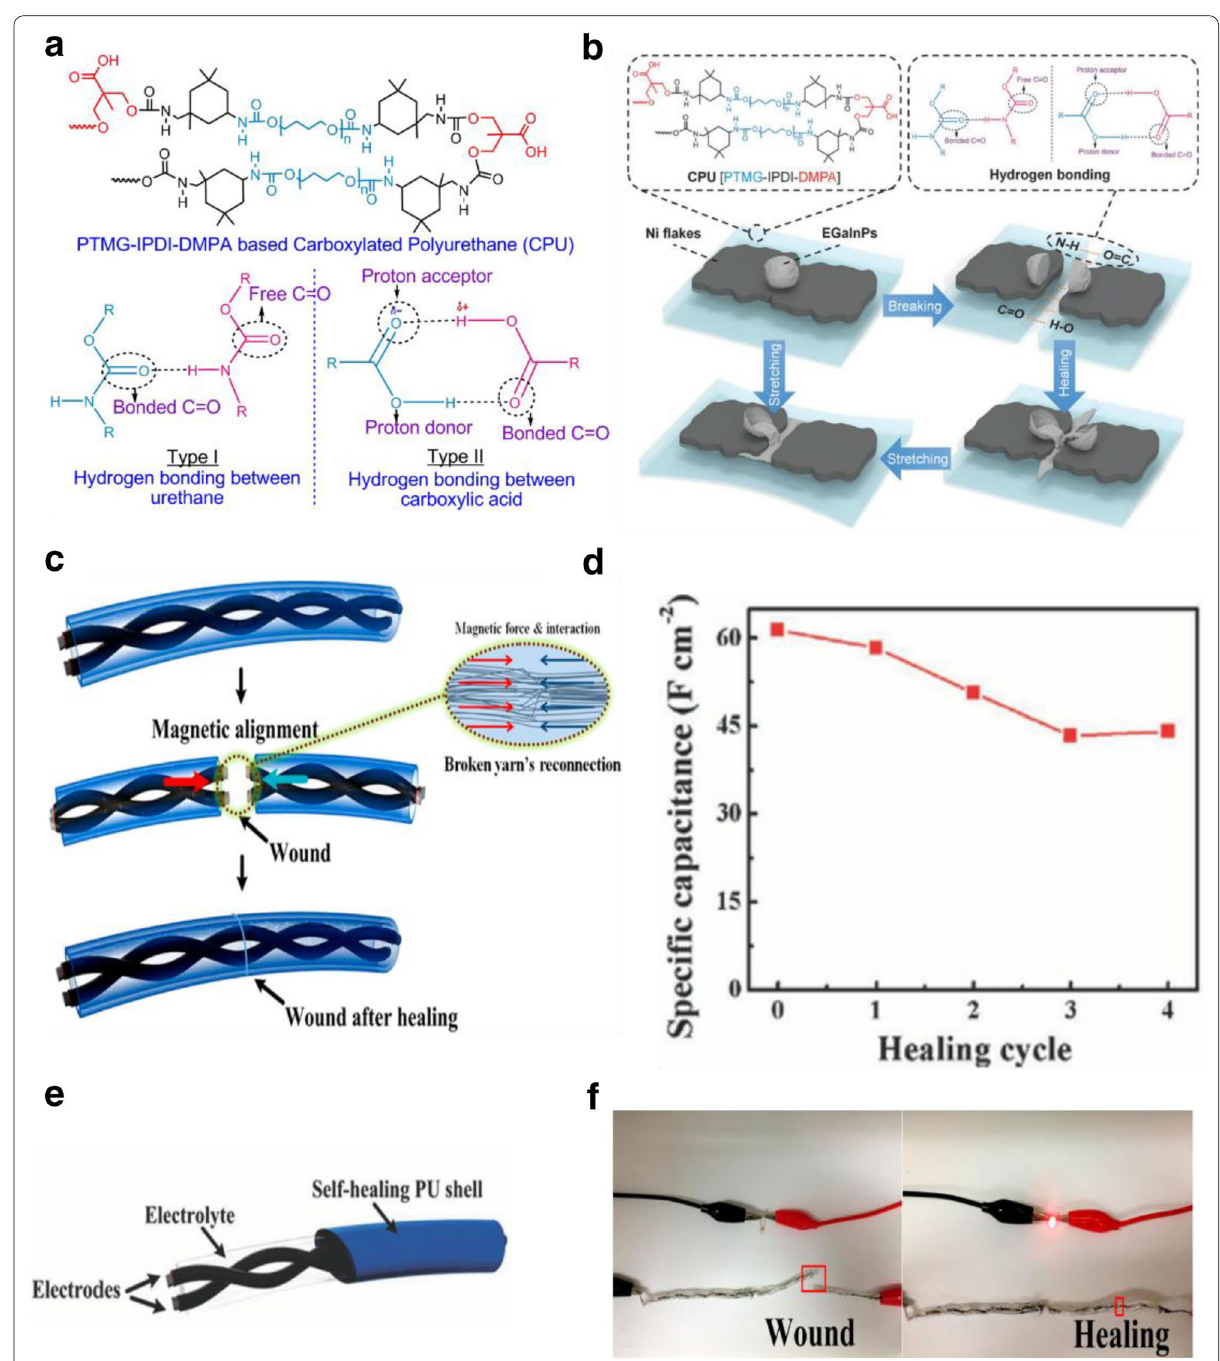
Fig. 3 a Schematics of the synthesis and hydrogen bonding mechanism of the CPU, wherein various stronger –COOH and weaker –NH–CO–O crosslinks are introduced to tune the mechanical properties of CPU; b schematics representation of mechanically and electrically self-healable and stretchable Ni flakes–EGaInPs–CPU conductor. The conductor electrically restored and mechanically healing activated due to the interfacial H-bonding of CPU with an efficiency of 97.5%; c schematic illustration of the self-healing process of supercapacitors. The demonstrated image shows the performance after self-healing on the fractured surfaces is fully based on the synergistic effect of magnetic electrodes and the CPU shell; d specific capacitance of the original device and after four breaking/healing cycles, which is restored to 71.8% due to the interfacial CPU shell. e Schematic structure of the magnetic-assisted self-healable yarn-based supercapacitor; f photographs of a self-healing supercapacitors connected in series to power an LED bulb (figures reproduced with permission from: a , b Ref. [59], ©2019 WILEY; c – f Ref. [61], ©2015